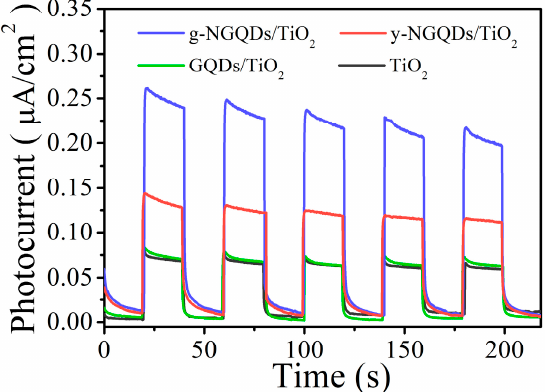
Figure 5. Transient photocurrent response spectra of TiO 2, GQDs/TiO 2 , g-NGQDs/TiO 2 and y-NGQDs/TiO 2 composites.